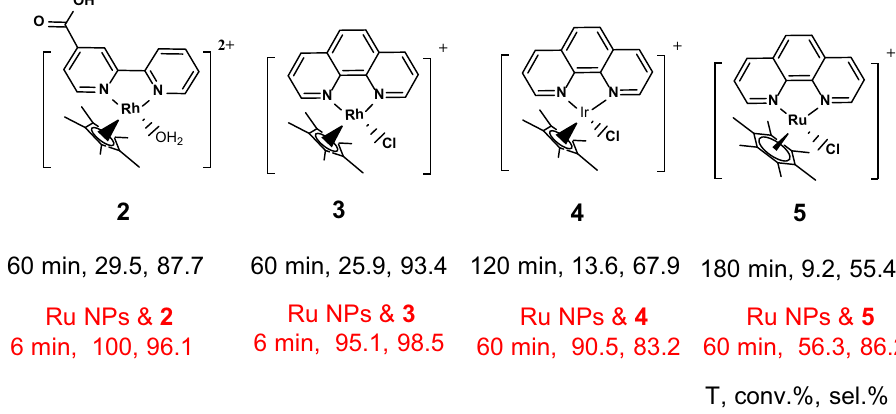
Fig.5|Structuresof2-5andtheirNAD + hydrogenationperformance. ReactionconditionswerethesameasthoseusedinFig.1exceptthat0.25 μ molIrand0.60 μ mol Ru complexes were